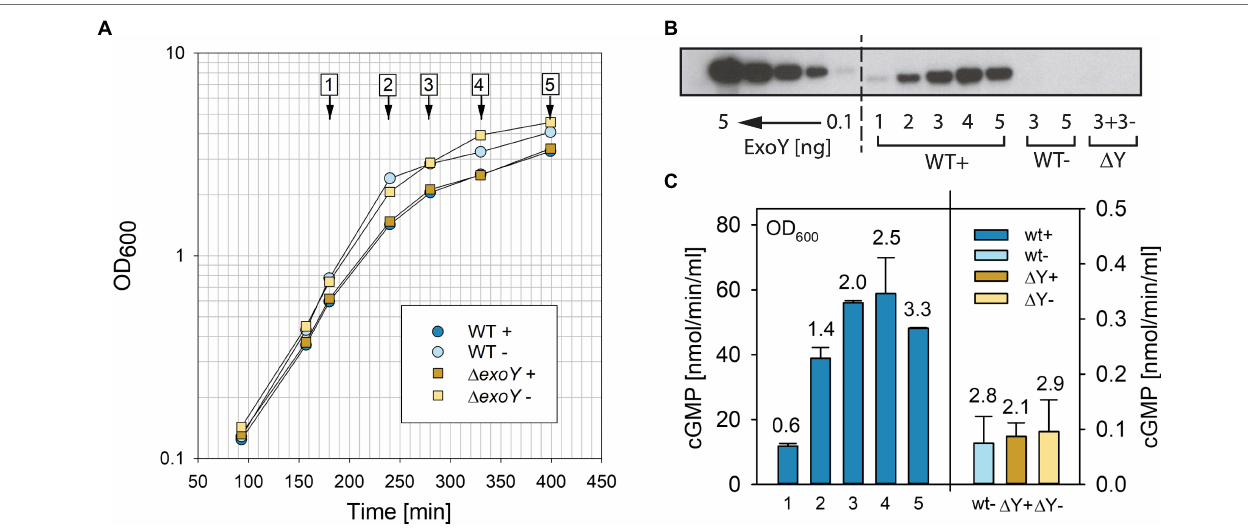
FIGURE 1 | Analyses of ExoY guanylate cyclase (GC) activity in bacterial culture supernatants of the reference strain PAO1F (WT) and the isogenic Δ exoY mutant ( Δ Y ). (A) Growth curves of Pseudomonas aeruginosa PAO1F and the isogenic Δ Y mutant grown in LB in the presence of 5 mM EGTA and 20 mM MgCl 2 to induce secretion of type III secretion system (T3SS) effectors (+) or under control conditions without induction ( − ). Numbers 1–5 represent time points where samples were taken and analyzed by (B) anti-ExoY Western blots and (C) GC activity assays. (B) Recombinant His-tagged ExoY or ExoY secreted from bacterial culture supernatants visualized by Western blot using polyclonal anti-ExoY antibodies against amino acid (aa) 26–223 of ExoY. Recombinant N-terminally His-tagged ExoY was used as standard and loaded at amounts of 0.1, 0.5, 1, 2.5, and 5 ng. (C) GC activity was measured in the presence of 3 μ M actin polymerized to steady state in 30 min reactions as described in Materials and Methods. Numbers above bars correspond to OD 600 at which samples were taken. Values correspond to averages of at least two measurements. Error bars indicate